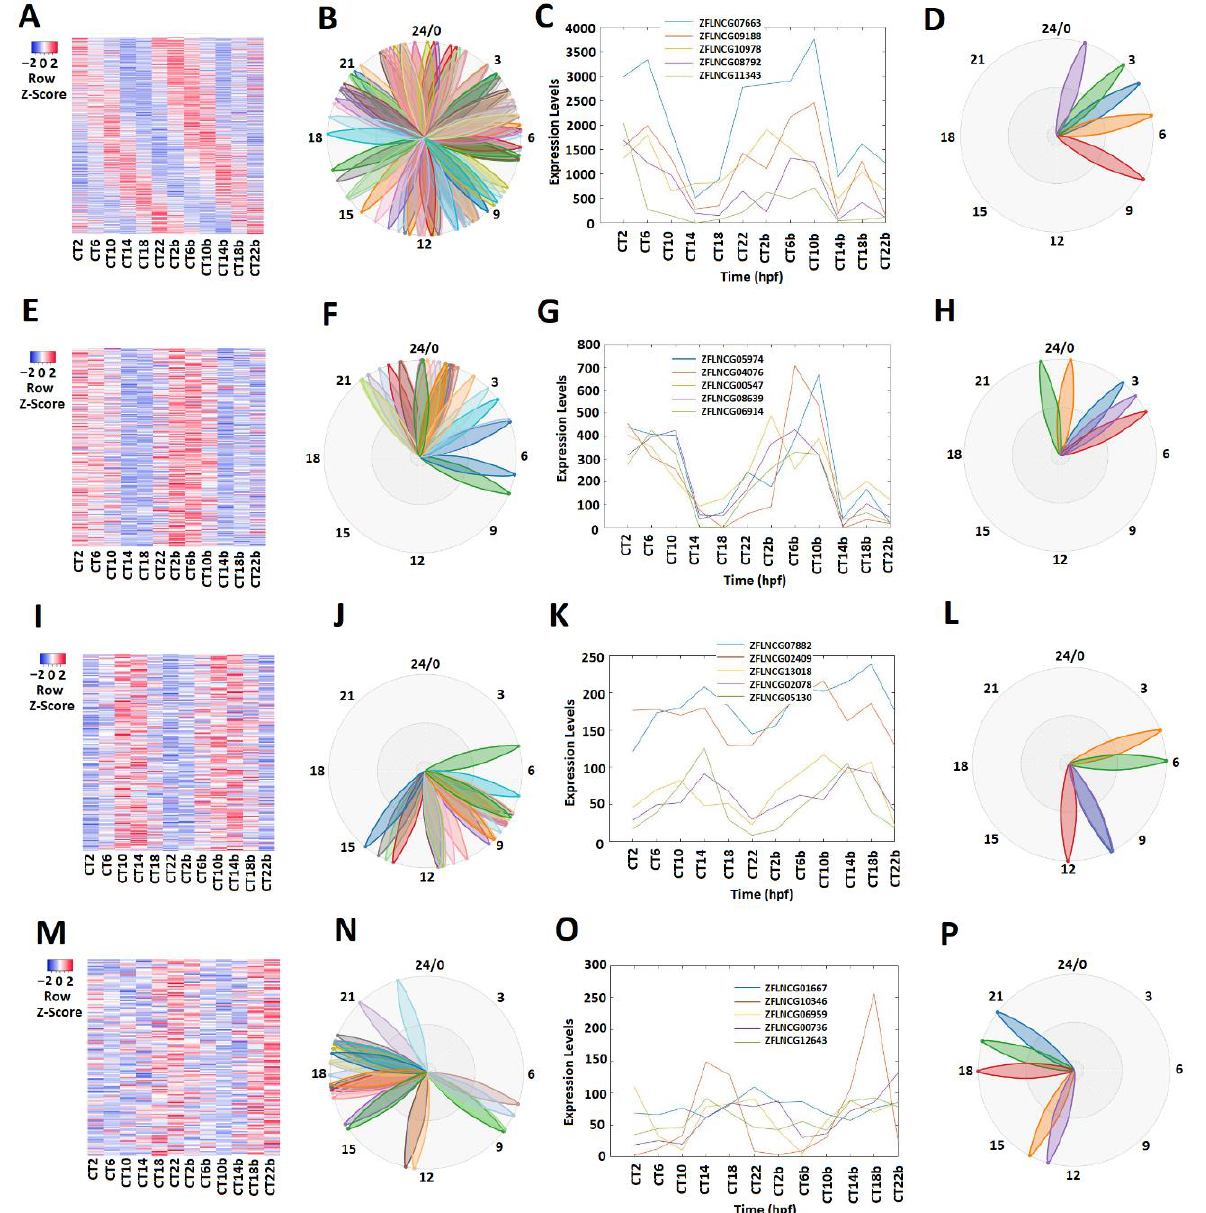
Figure 1. Expression profile analysis of morning (CT 2 and CT 6), evening (CT10 and CT14), and night (CT18 and CT22) rhythmically expressed pineal gland lncRNAs. Analysis of all 586 rhythmically expressed pineal gland lncRNAs ( A – D ): heat map ( A ) and phases ( B ) of all 586 rhythmically expressed pineal gland lncRNAs; expression profiles ( C ) and phases ( D ) of representative lncRNAs. Analysis of 241 pineal gland morning lncRNAs ( E – H ): heat map ( E ) and phases ( F ) of 241 pineal gland morning lncRNAs; expression profiles ( G ) and phases ( H ) of representative pineal gland morning lncRNAs. Analysis of 196 pineal gland evening lncRNAs ( I – L ): heat map ( I ) and phases ( J ) of 189 pineal gland evening lncRNAs; expression profiles ( K ) and phases ( L ) of representative pineal gland evening lncRNAs. Analysis of 149 pineal gland night lncRNAs ( M – P ): heat map ( M ) and phases ( N ) of 217 pineal gland night lncRNAs; expression profiles ( O ) and phases ( P ) of representative pineal gland night lncRNAs.